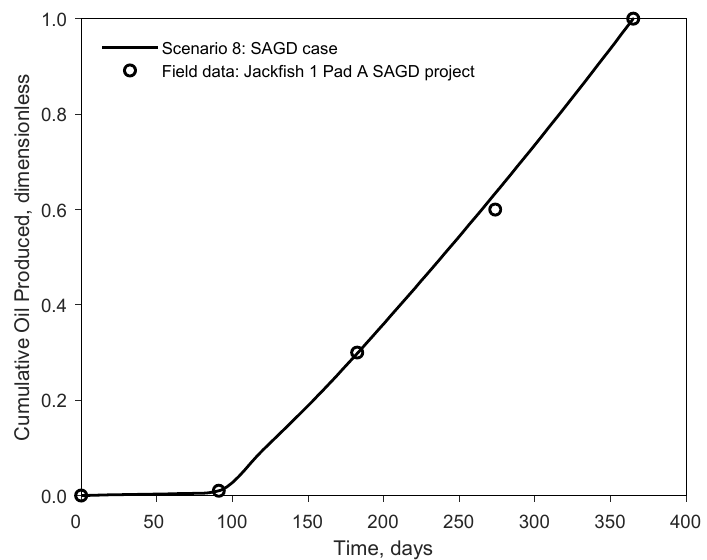
Figure 10. Comparison of the cumulative oil production results of simulation scenario 8 and the Jackfish 1, Pad A (Athabasca oil sands) SAGD project.